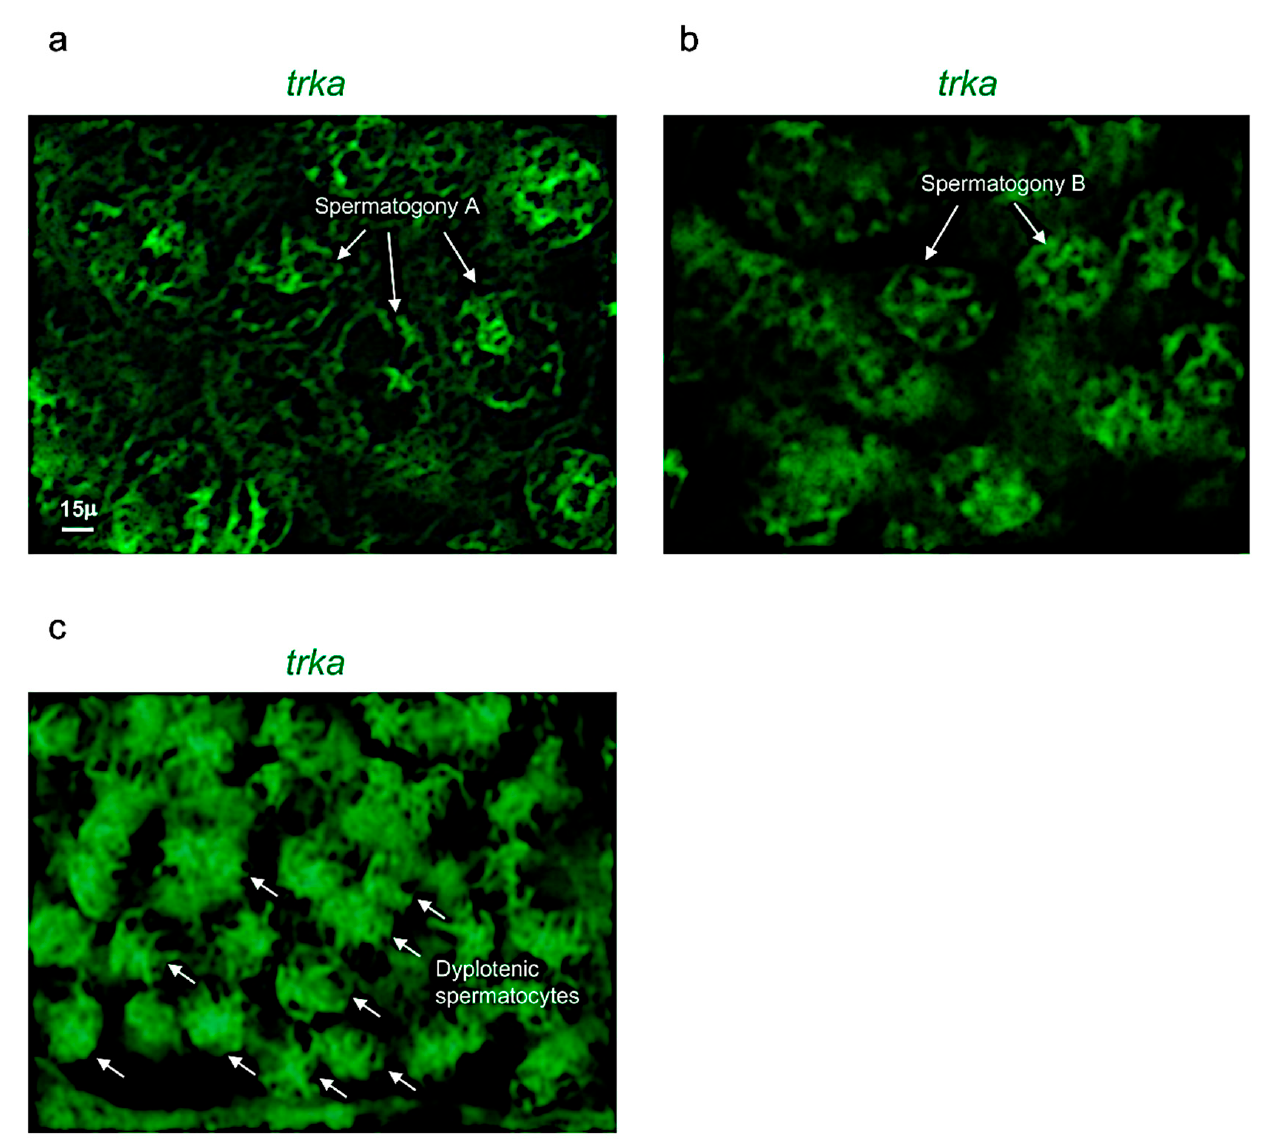
Figure 5. Trka is specifically expressed in spermatogony A, B and dyplotenic spermatocytes. High magnification, fluorescence in situ hybridization of ngf , specifically expressed in ( a ) spermatogony A; ( b ) spermatogony B; and ( c ) dyplotenic spermatocytes in adult zebrafish testis. Scale bar: 15 µ ( a – c ).